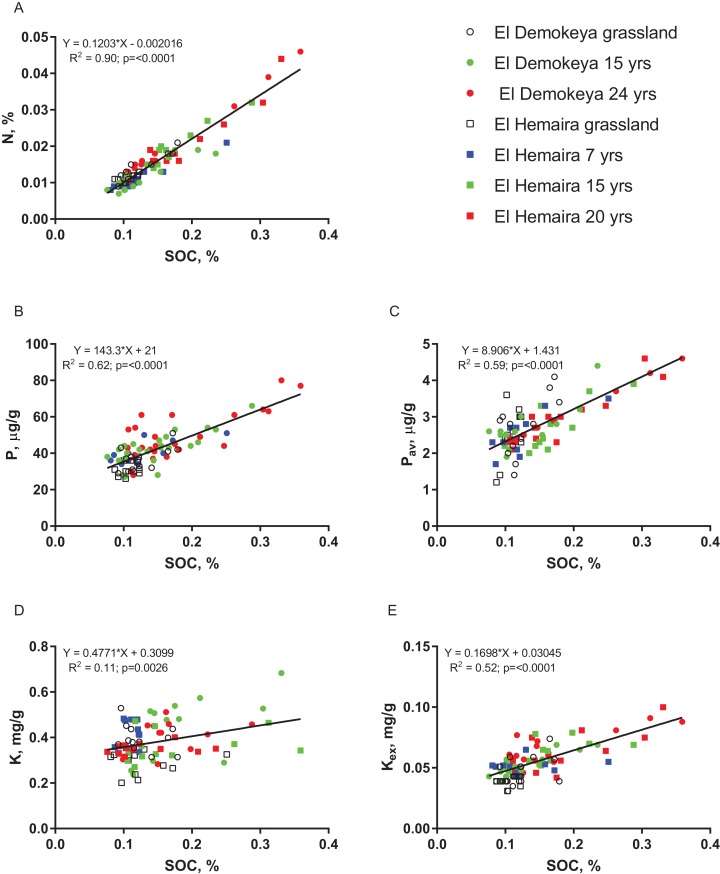
Dependence of soil N (A), total P (B), available P (C), total K (D) and exchangeable K (E) on SOC concentrations for grassland and plantations by age across all soil layers and for the two study sites.